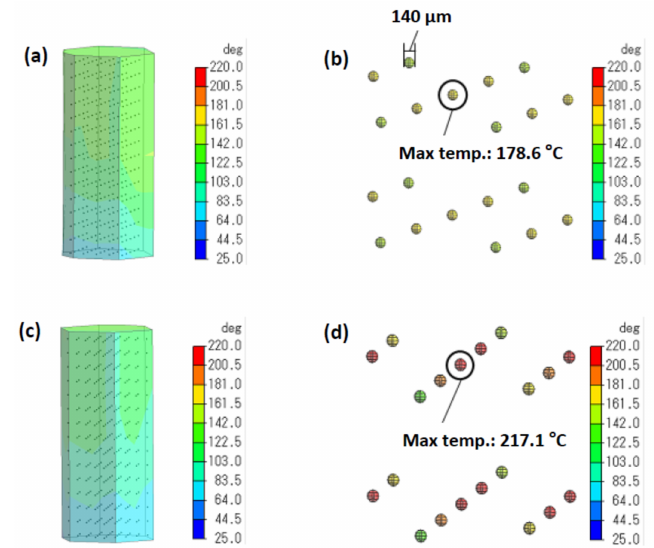
Figure 5. ( a , c ) Colored images displaying the results of the simulated temperature distribution while irradiating the reactor with the 2.90 W microwaves and with the 5.60 W microwaves with air cooling, respectively. ( b , d ) Heterogeneous sulfonated activated carbon particulates heated using the 2.90 W microwaves and the 5.60 W microwaves with air cooling, respectively. The red-colored particulates in ( d ) reflect the higher temperature distribution on the particle